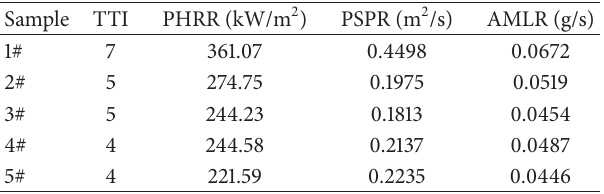
Table 2: Data obtained from cone calorimeter testing of